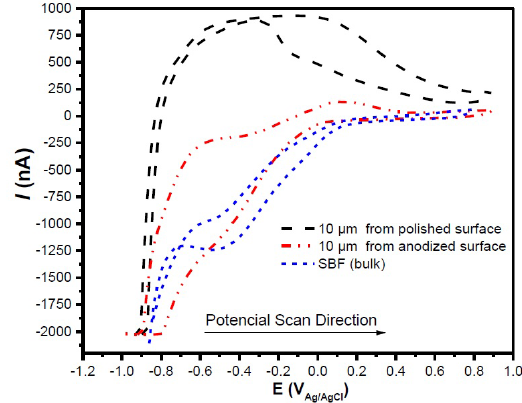
Figure 3. Cyclic voltammograms of Pt UME above AZ31B surface at the OCP after 10 minutes of immersion in SBF solution at a scan rate of 25 mV s -1 .